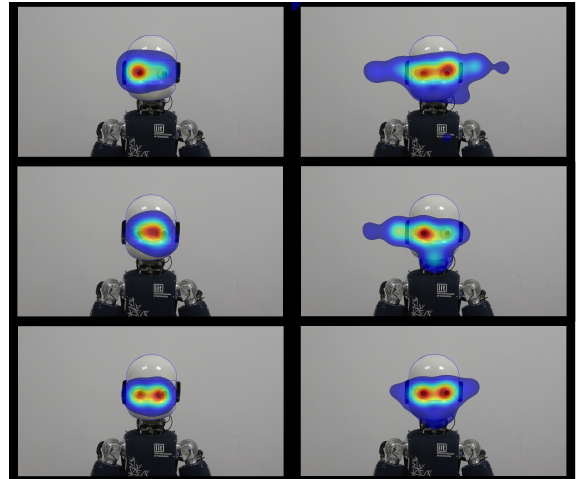
Figure4: FixationheatmapsforeachrTTconditionacrosstheexper- iment.Ontheleft:trialonsetuntilheadmovement;ontheright:head movement until the end of the